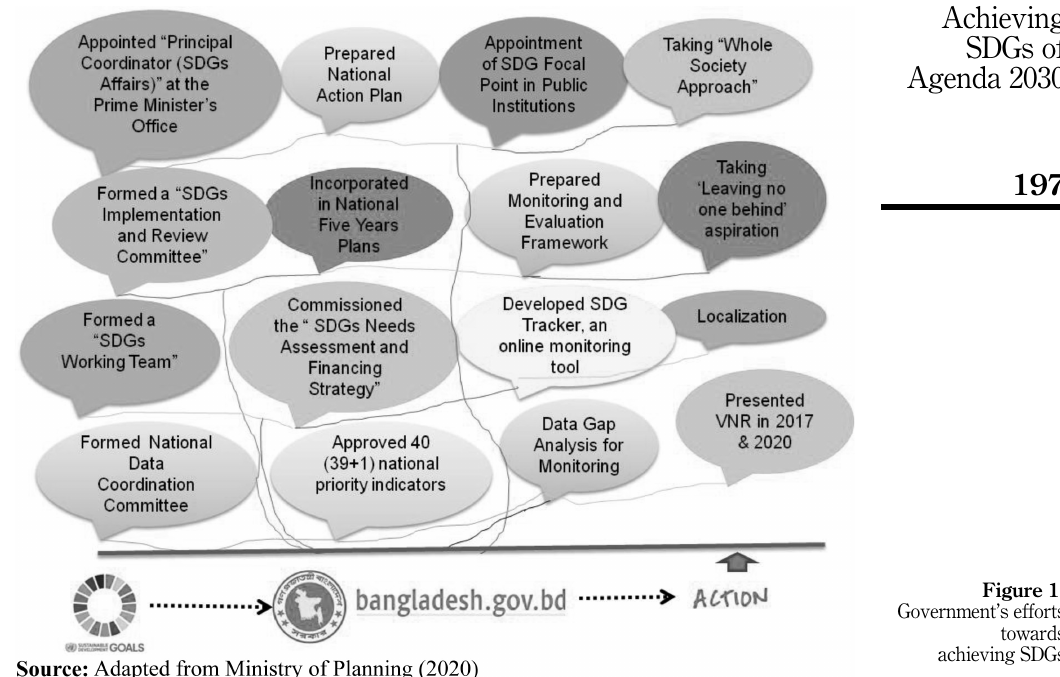
Figure 1. Government ’ s